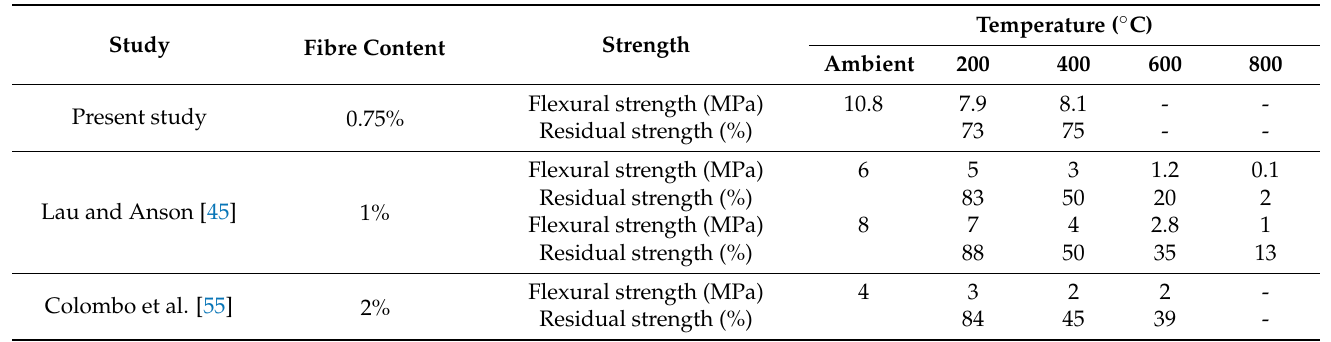
Table 4. Comparison of residual flexural strengths of steel fibre reinforced composites at elevated temperatures.